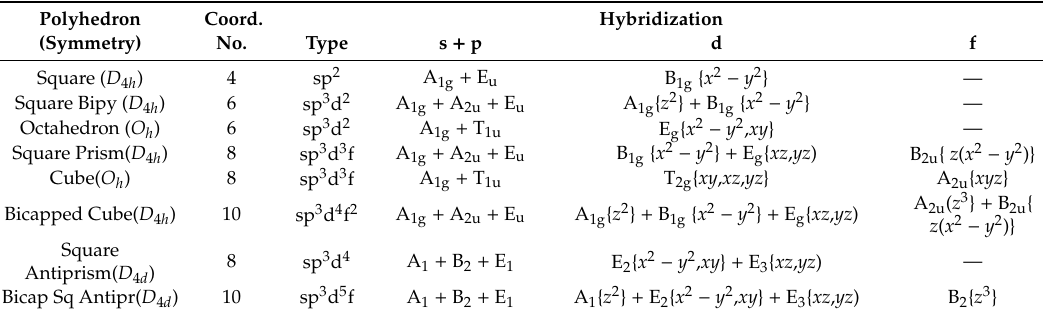
Table 3. Hybridization schemes for the tetragonal polyhedra.